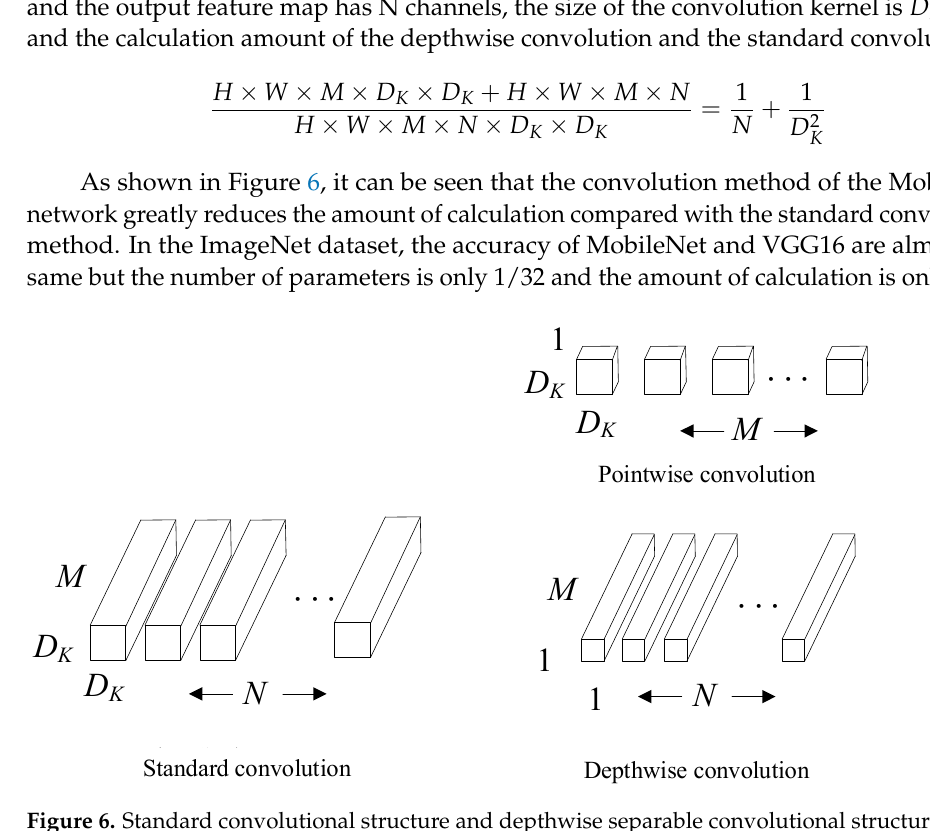
Figure 6. Standard convolutional structure and depthwise separable convolutional